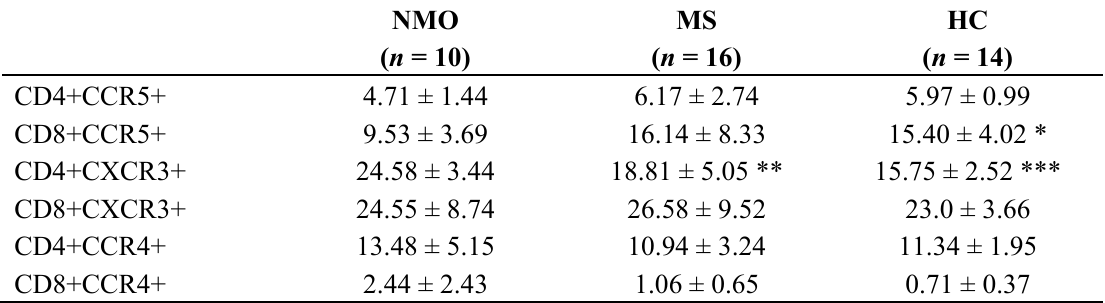
Table 1. Baseline of chemokine receptor expression on blood T cells.